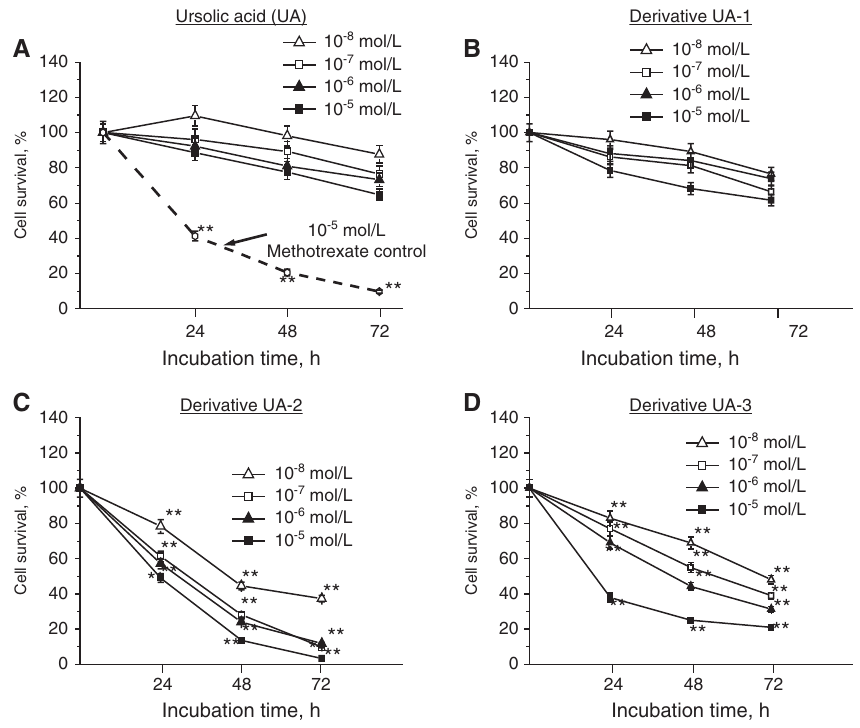
Figure 2 Effect of various doses of ursolic acid and its derivatives on time-dependent (0–72 h) survival of HepG2 human hepatoma cells using methotrexate as control. All values are mean ± standard error of samples (in triplicate) from four different experiments in each group. (**p < 0.01: indicate significance of difference between ursolic acid derivative treatment compared to ursolic acid